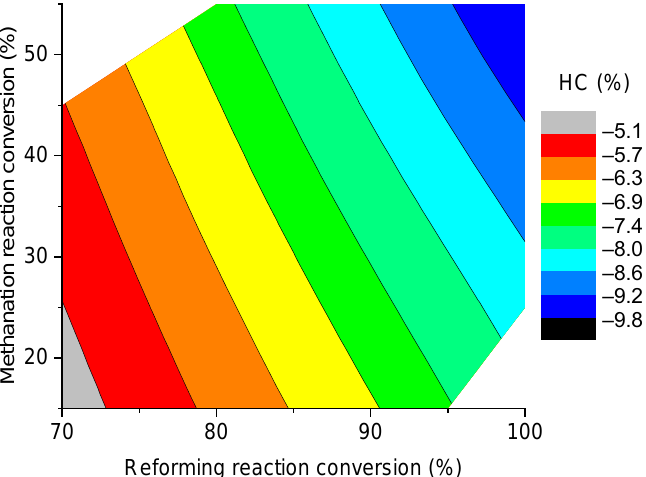
Figure 7. HC for different reforming and methanation conversion values.